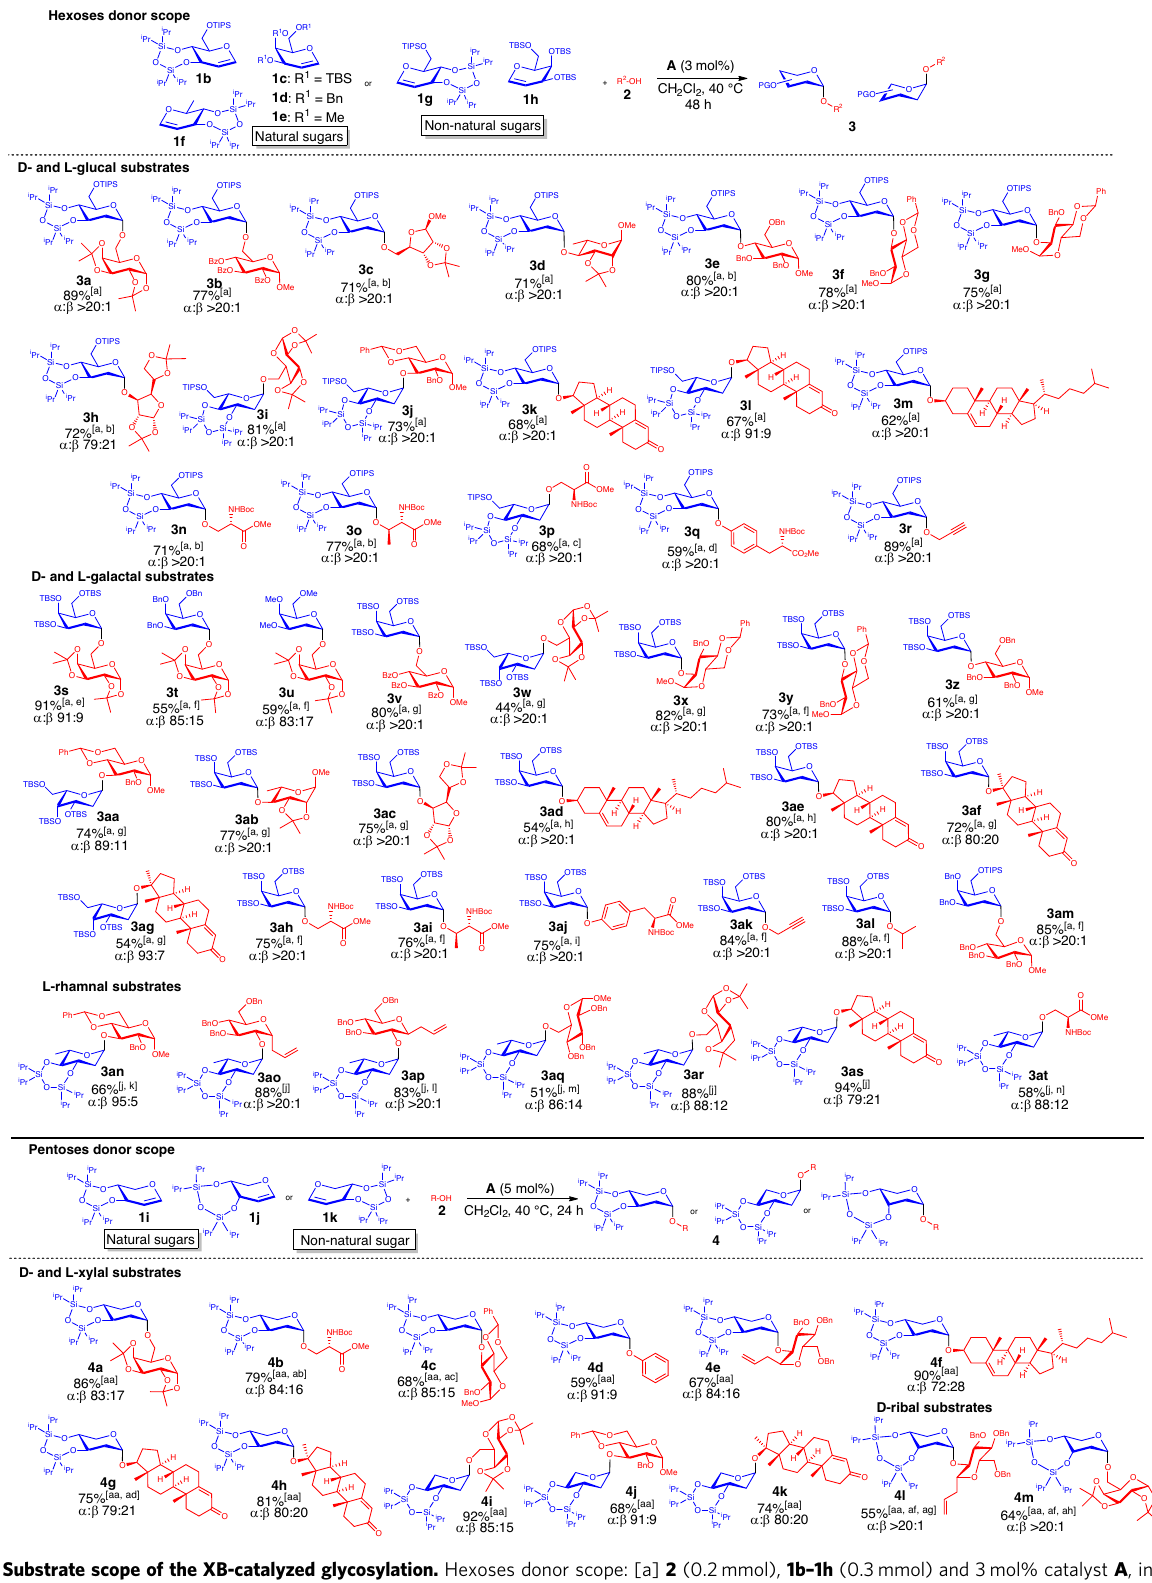
Fig. 3 Substrate scope of the XB-catalyzed glycosylation. Hexoses donor scope: [a] 2 (0.2 mmol), 1b – 1h (0.3 mmol) and 3 mol% catalyst A , in CH 2 Cl 2 (1 mL), argon, 40 °C, 48 h; α : β ratio was determined by crude 1 H NMR analysis. [b] 5 mol% catalyst A , 50 °C. [c] 5 mol% catalyst A , 50 °C, 72 h. [d] 5 mol % catalyst A , 50 °C, 108 h. [e] RT, 24 h. [f] 30 °C. [g] 30 °C, 72 h. [h] 30 °C, 24 h. [i] 10 mol% catalyst A , 40 °C, 96 h. [j] 2 (0.2 mmol), 1 f (0.4 mmol) and 5 mol% catalyst A , in CH 2 Cl 2 (1 mL), argon, 30 °C, 48 h. [k] 108 h. [l] 40 °C. [m] 96 h. [n] 50 °C, 72 h. Pentoses donor scope: [aa] 2 (0.2 mmol), 1i – k (0.3 mmol) and 5 mol% catalyst A , in CH 2 Cl 2 (1 mL), argon, 40 °C, 24 h; α : β ratio was determined by crude 1 H NMR analysis. [ab] 96 h. [ac] 30 °C, 48 h. [ad] 48 h. [ae] 3 mol% catalyst A , 30 °C, 48 h. [af] 1j (0.4 mmol). [ag] 3 mol% catalyst A , 35 °C, 48 h. [ah] 3 mol% catalyst A , 30 °C. RT = room temperature 23 °C, PG = Protecting